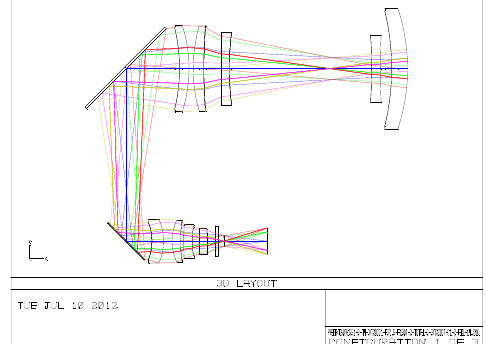
Fig.1 The structure of the zoom optical